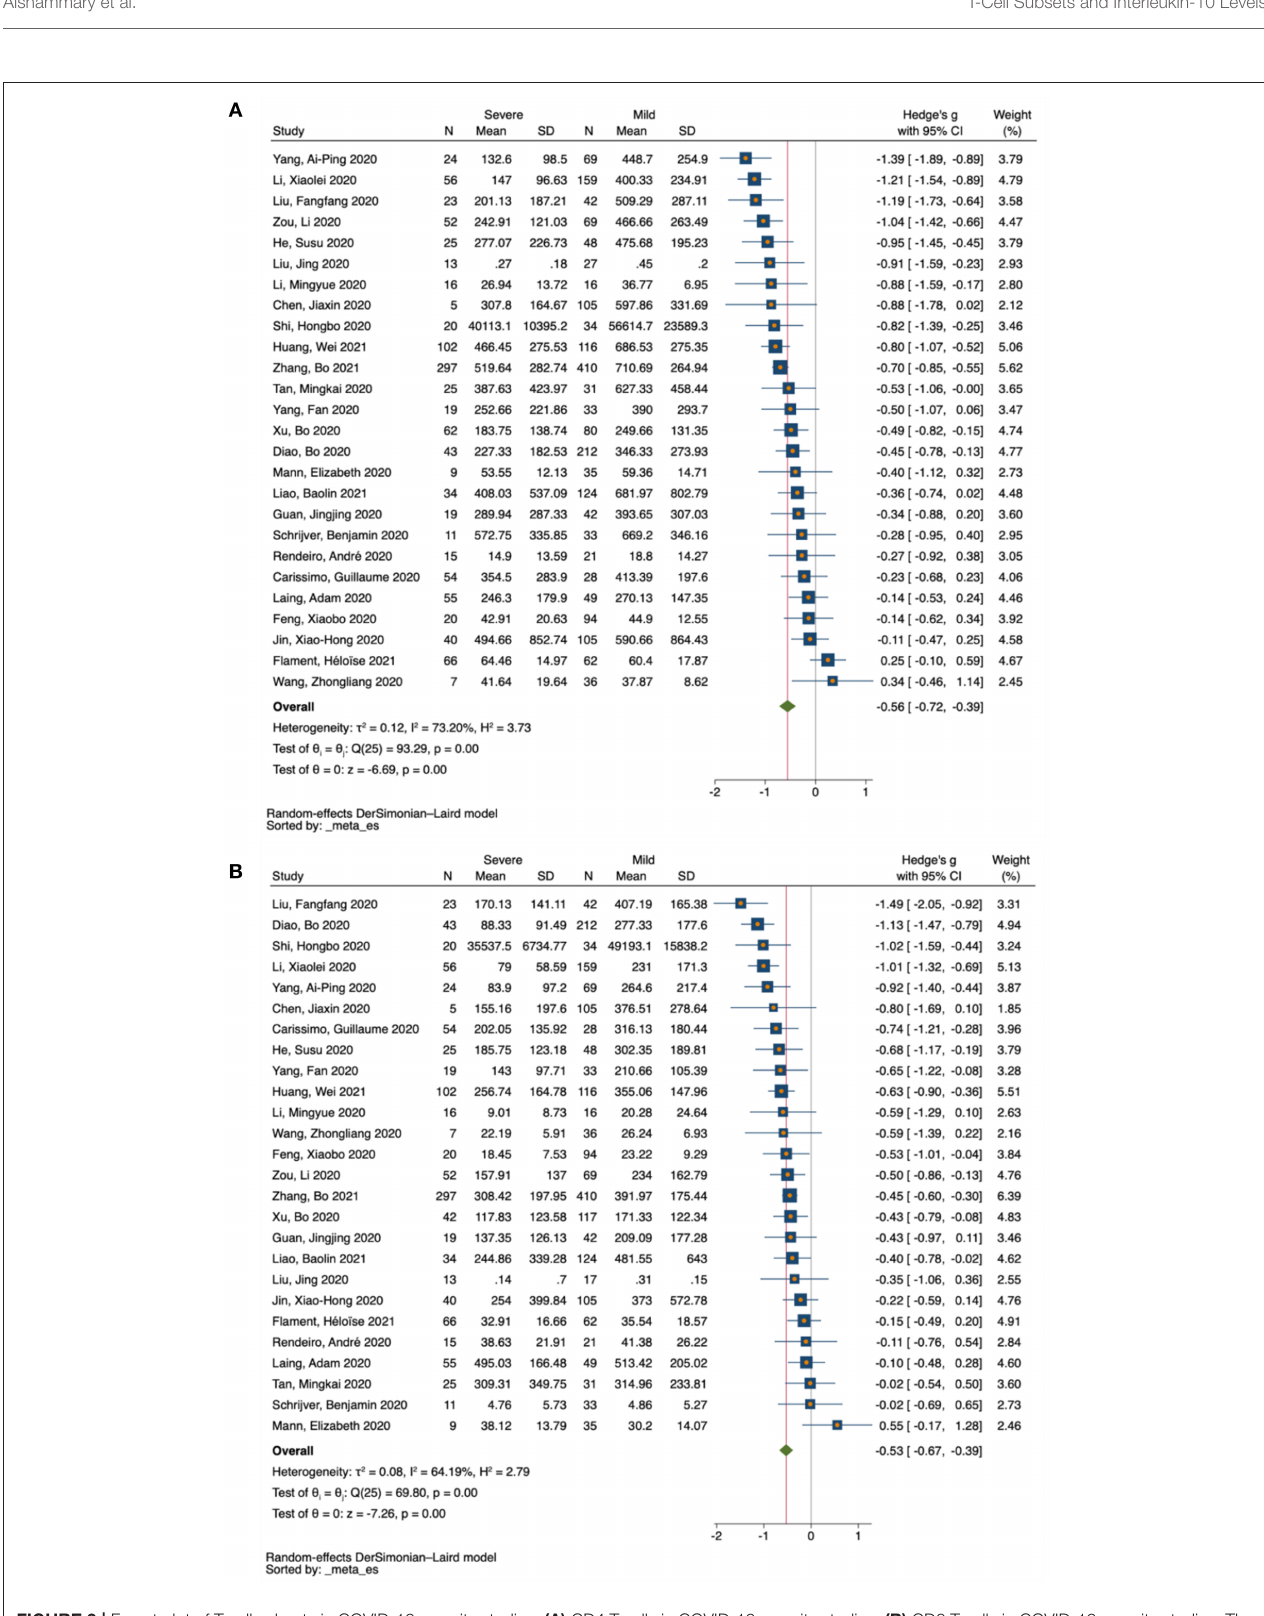
Frontiers in Medicine |